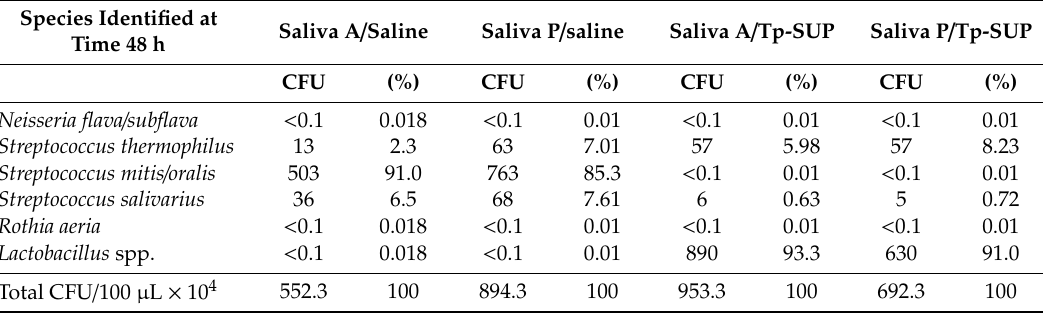
Table 3. Microbial re-growth onto saliva-contaminated and Tp-SUP treated